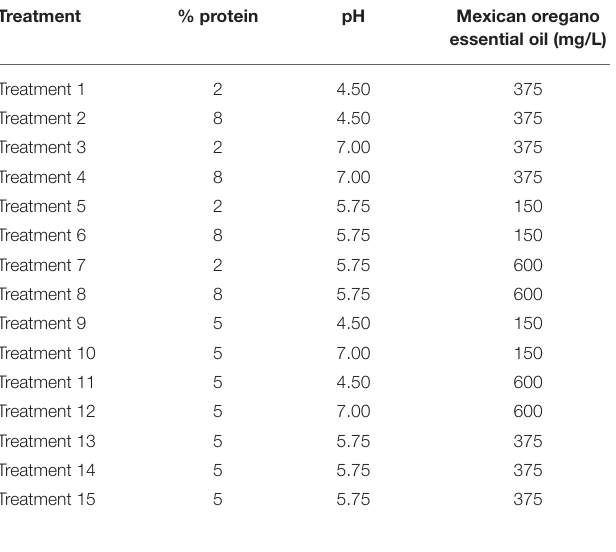
TABLE 3 | Parameters of the modified Gompertz equation for radial growth of Penicillium expansum and Aspergillus ochraceus , using Lippia berlandieri Schauer essential oil with high carvacrol content in combination with pH and protein content. Penicillium